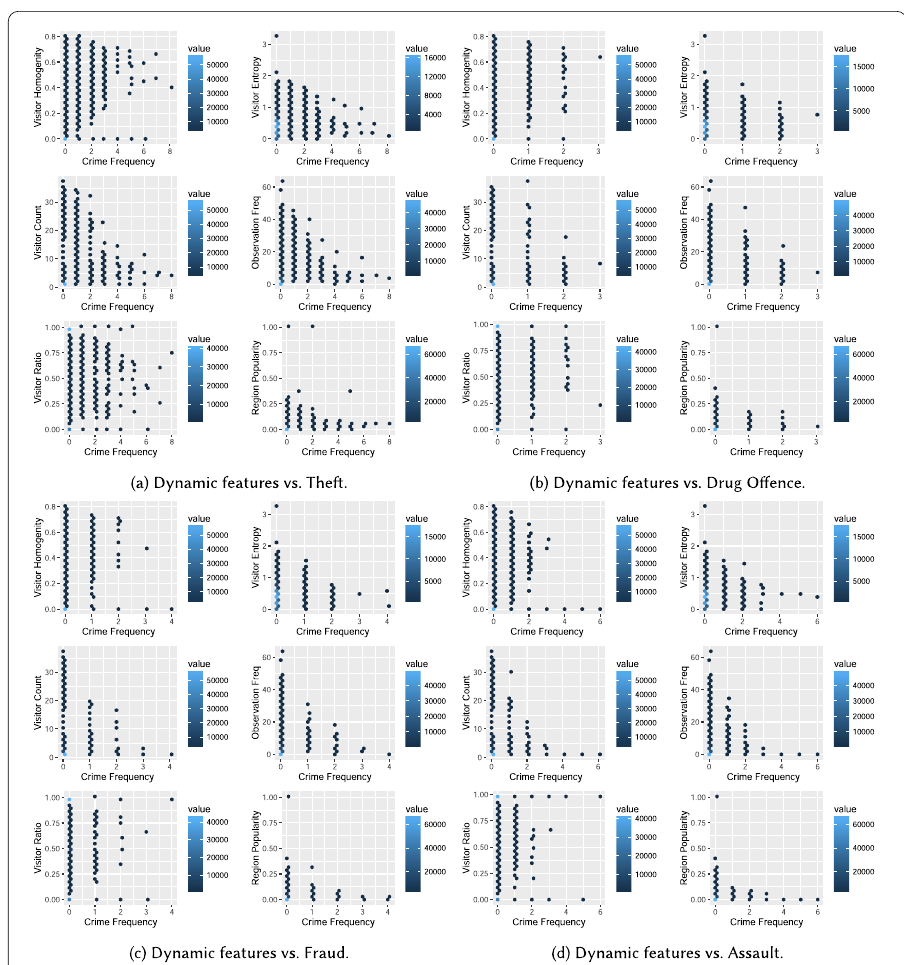
Figure 3 Correlation between dynamic features and crime event occurrences in the interval [15–18) in New York City